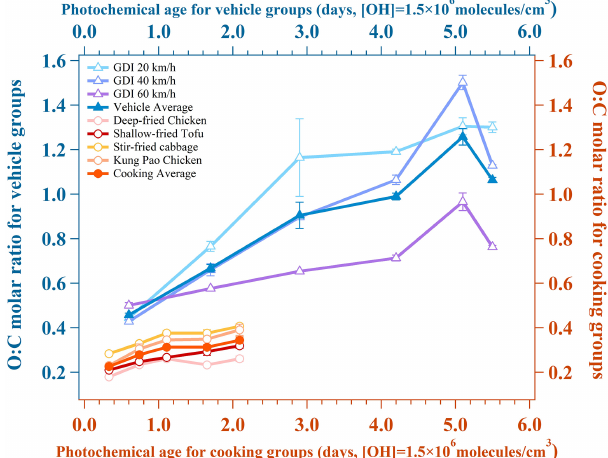
Figure 3. Evolution of O : C molar ratio for two urban-lifestyle OAs. The O : C molar ratios are determined by an HR-ToF-AMS. The average data and standard deviation bars at each gradient are shown in the